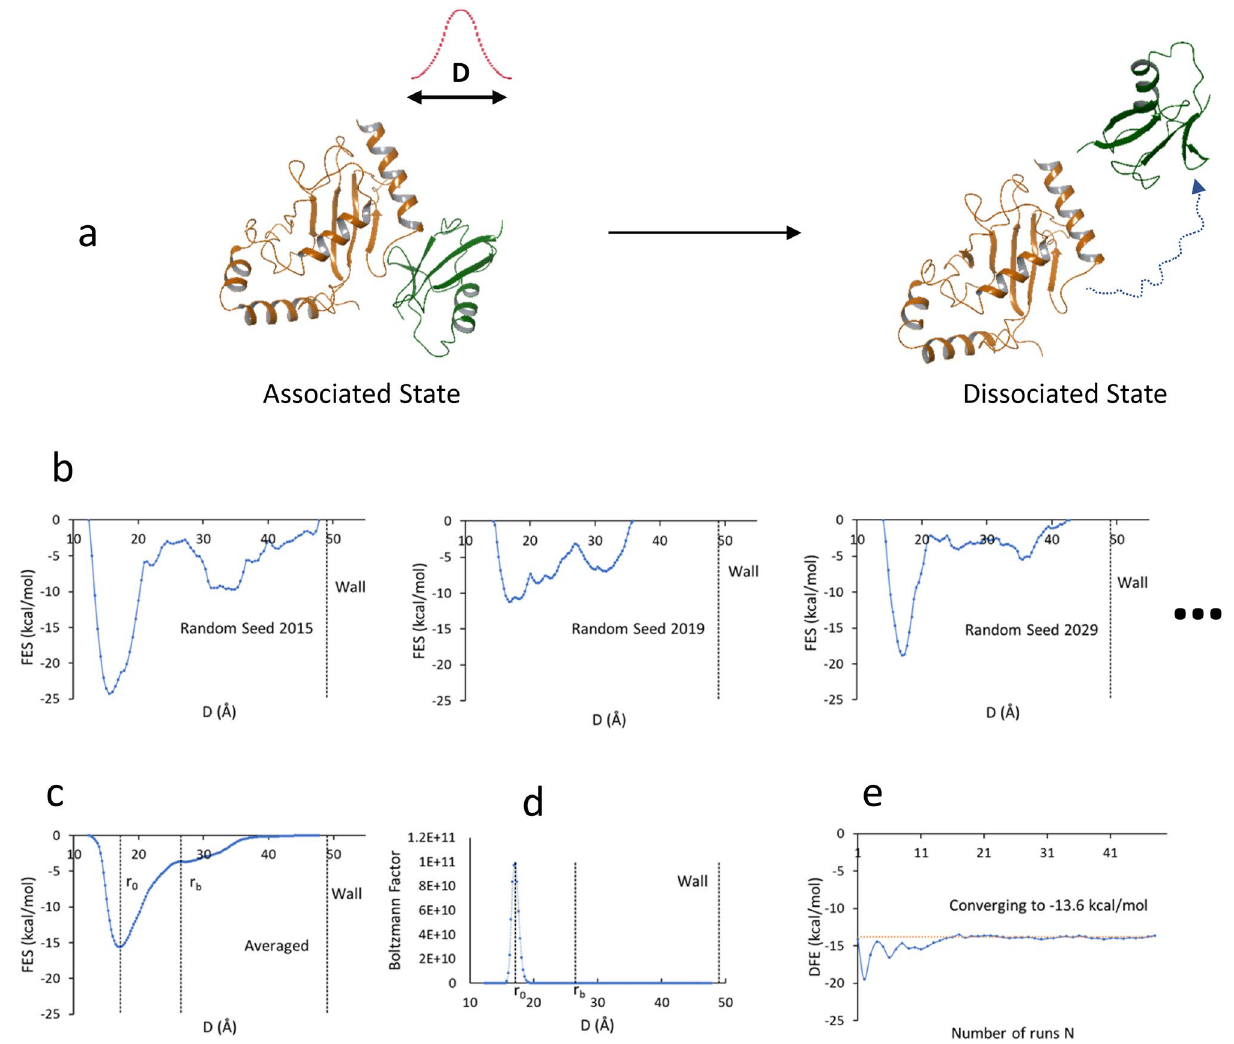
Figure 1. Concept and workflow of a DFE calculation. ( a ) One-way trip dissociation of a molecular complex by running metadynamics using an intermolecular distance D as CV. The dotted curve on the right panel is an illustrative trajectory of the centroid of the CV residue of protein B (green ribbon). ( b ) Primitive FES from a number of replicas of different random seeds, noting that a wall is placed in each run. ( c ) Average FES stemming from an ensemble of primitive FES, noting the position r 0 of the bound state minimum and the boundary r b separating the bound state region and the free state region. ( d ) Boltzmann factor as a function of D, narrowly concentrated around r 0 . ( e ) Convergence analysis: DFE is iteratively calculated as more and more replicas enter into averaging, showing that DFE converges when a sufficient number of replicas are potential energy of the system at every time interval along the progression of the simulation, which forces the CV to increase, leading to the dissociation of the molecules (see Fig. 1a). Unlike the usual metadynamics procedures which seek repeated back-and-forth sampling to achieve the convergence condition 16–18 , this procedure performs a number of one-way trip runs. In each run, the system undergoes dissociation and does not re-associate due to the immense space available to explore in the dissociated state. In such a run, how long the system stays in the bound (associated) state depends on the free energy well or the intrinsic stability of the complex, while how long it stays in the free (dissociated) state is arbitrary depending on the simulation time. As long as the system stays in the bound state, Gaussian energies will continuously be added into that region. When the accumulation of the Gaussian energies fills up the bound state well, the system exits from the bound state. Therefore, the accumulated Gaussian energies of the bound state provide the raw data from which we can calculate a free energy quantity, namely the DFE of the system. DFE can be understood as a measure of the degree of difficulty of pushing the system out of the bound state region. The Gaussian energies added into the free state do not contribute to this DFE and can be ignored. Giving that a single run inevitably includes errors associated with the random nature of the simulation, multiple runs are performed until the calculated DFE converges to a stable value. According to the metadynamics terminology, the distribution of the accumulated Gaussian energies (functions) is called the